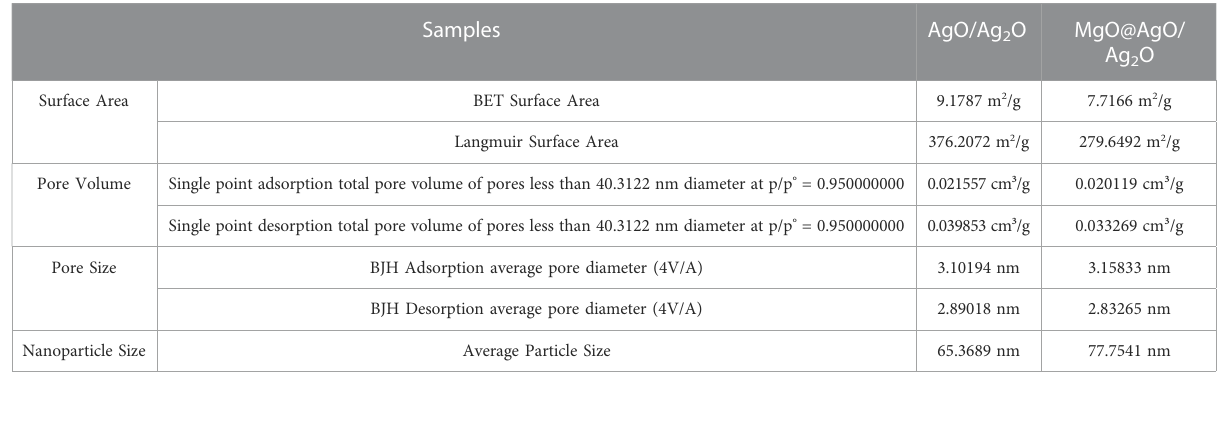
TABLE 2 BET surface area, porosity, and particle size of AgO/Ag 2 O and MgO@AgO/Ag 2 O